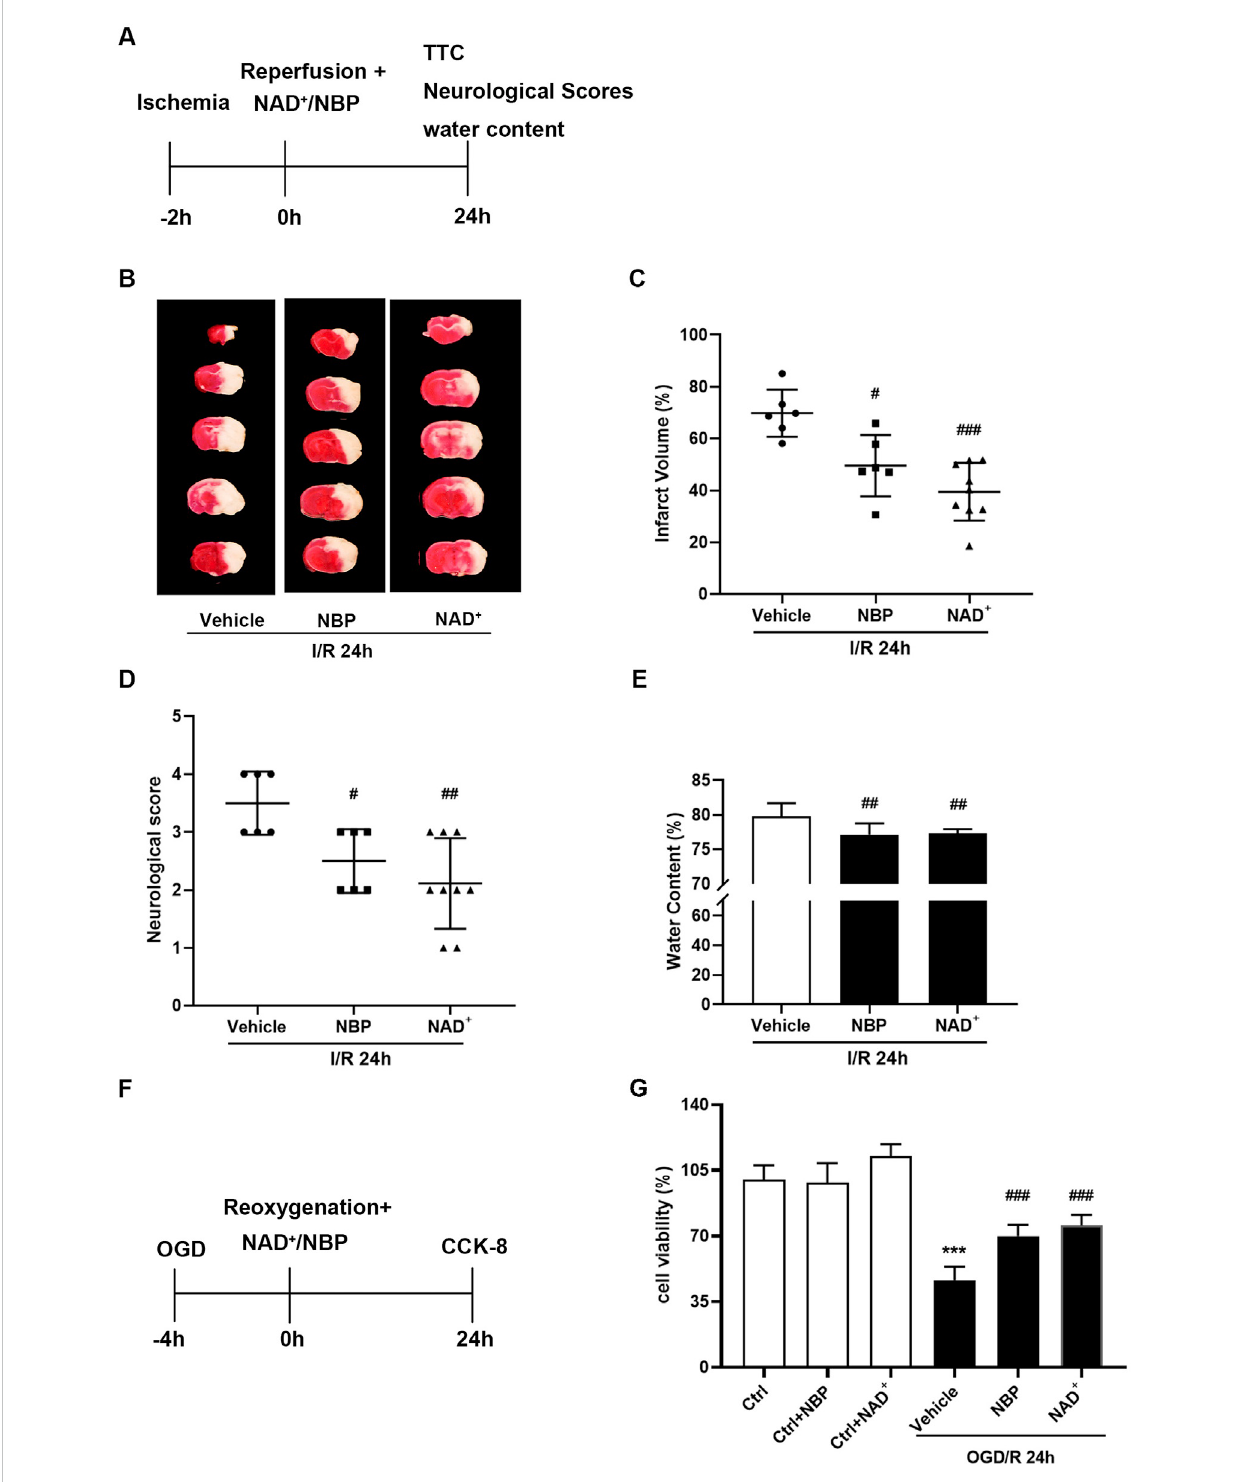
FIGURE 3 Comparison of the effects of NBP and NAD + in the treatment of ischemic stroke. (A) In mice, MCAO was performed for 2 h, and NBP (30 mg/kg) or NAD + (50 mg/kg)wereadministratedtomiceassoonaspossibleafterreperfusion.MCAO/R-treatedmiceweresacri fi ced24 haftertheprocedure. (B,C) TTC staining was used to measure the cerebral infarct volume. (D) The neurological de fi cit score at 24 h after reperfusion. (E) The brain water content at 24 hafter reperfusion.Therewereatleastsixanimalsineachgroup. (F) Glucose andhypoxia weretakenawayfromtheprimary corticalneuronsfor 4 h, and 15 mM NAD + or 5 μ M NBP were administered transiently after reperfusion. After 24 h of reperfusion, the viability of the cells was determined usingtheCCK-8kit. (G) Cellviabilityineachgroup.n=6pergroup. ***p < 0.001vs.ctrl, # p < 0.05, ## p < 0.01, ### p < 0.001vs.vehiclebyOne-wayanalysis of ANOVA followed by Tukey ’ s multiple comparisons test. Data were expressed as the mean ±